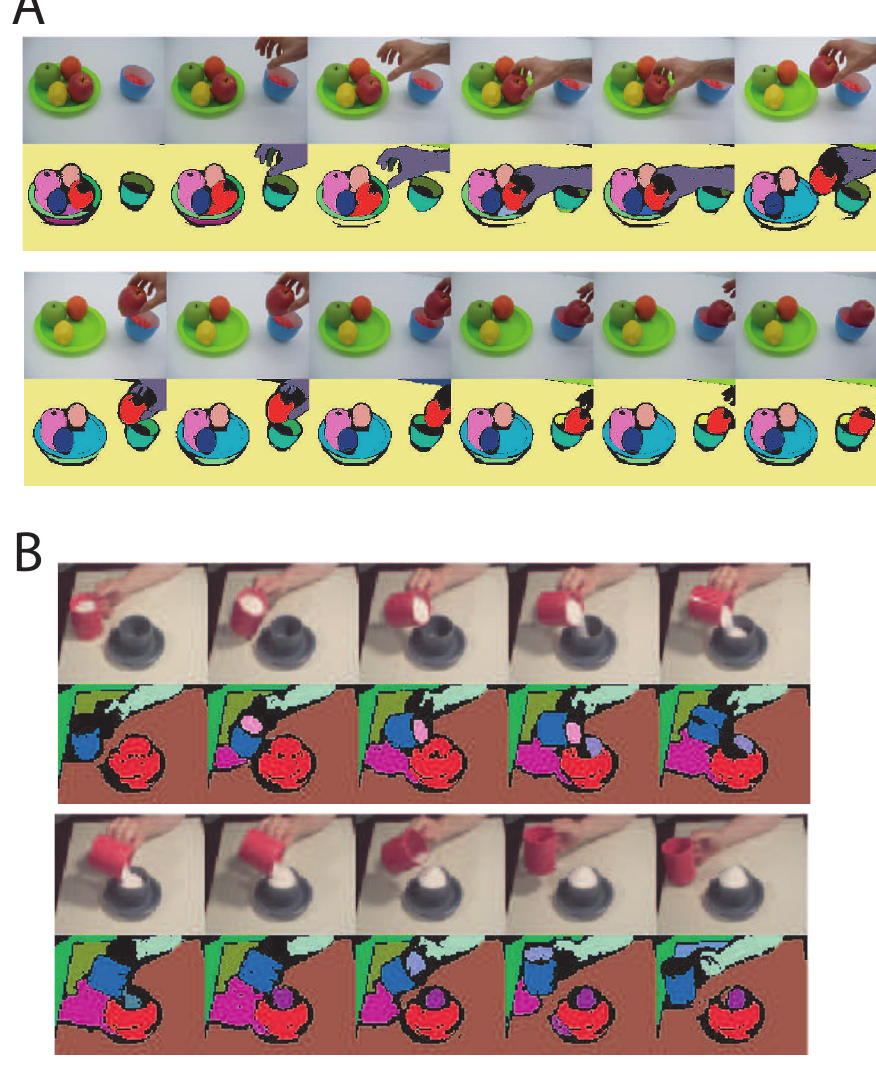
Figure 7. Segment tracking for real movies. A The algorithm (with feedback control) is applied to a movie showing a hand taking an apple from a plate (upper panel). The corresponding segment-tracking results are depicted below. B The results of the algorithm (with feedback control) for a movie showing the filling of a cup are shown. Segment-tracking results for other real movies can be found at http://www.nld.ds.mpg.de/ ∼